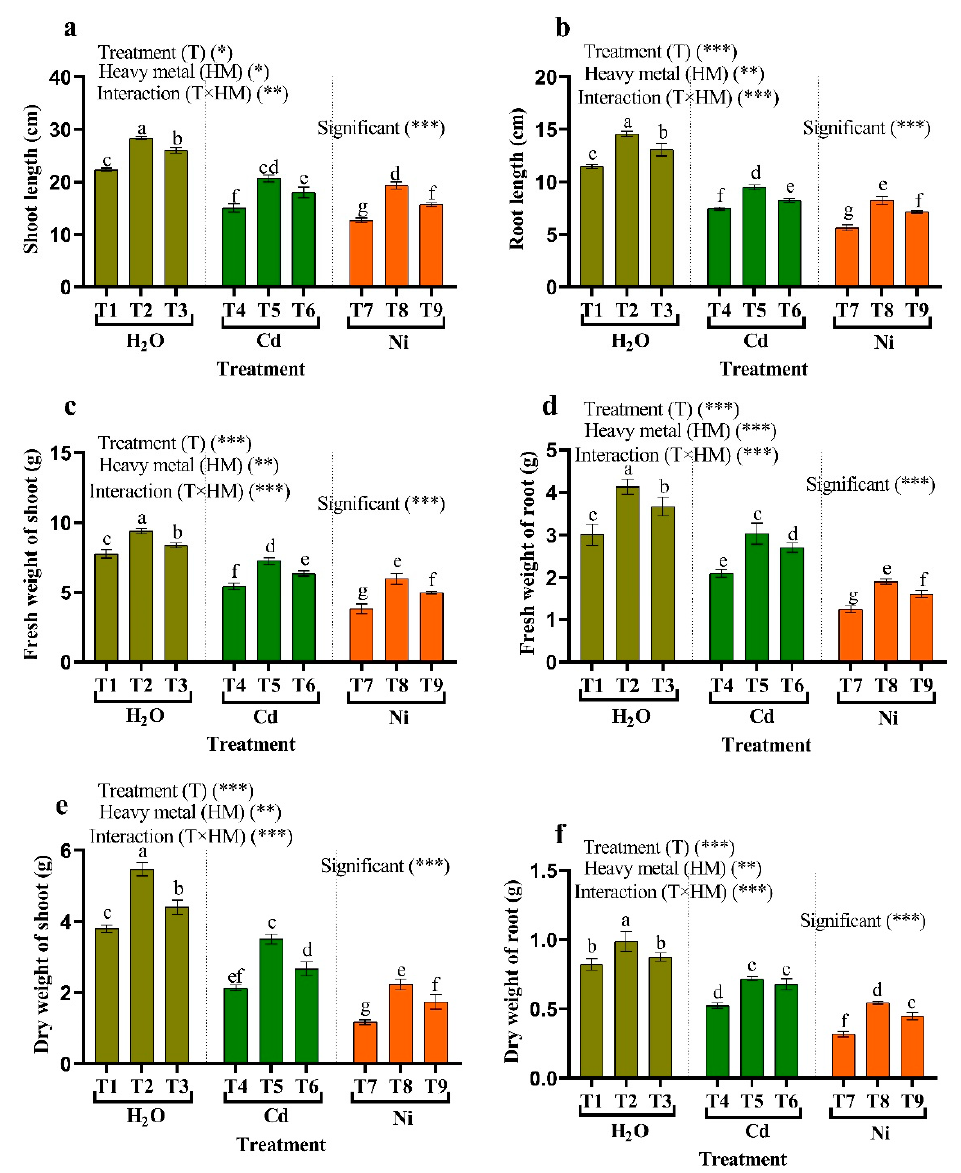
Figure 3. The influence of endophytic bacteria on ( a ) shoot length, ( b ) length of the root, ( c ) fresh weight of shoot, ( d ) dry weight of shoots, ( e ) fresh weight of the root, ( f ) dry weight of the root in tomato plants growing under HM stress. Fisher’s test at p < 0.05 reveals significant variations in means ( ± standard error), which are different letters (a–g) on the same bars. *, ** and *** imply significance levels of 0.01 and 0.05, respectively. T1: (Control with tap water), T2: Micrococcus luteus , T3: Enterobacter cloacae , T4: 50 µ M Cd, T5: Micrococcus luteus + 50 µ M Cd, T6 : Enterobacter cloacae + 50